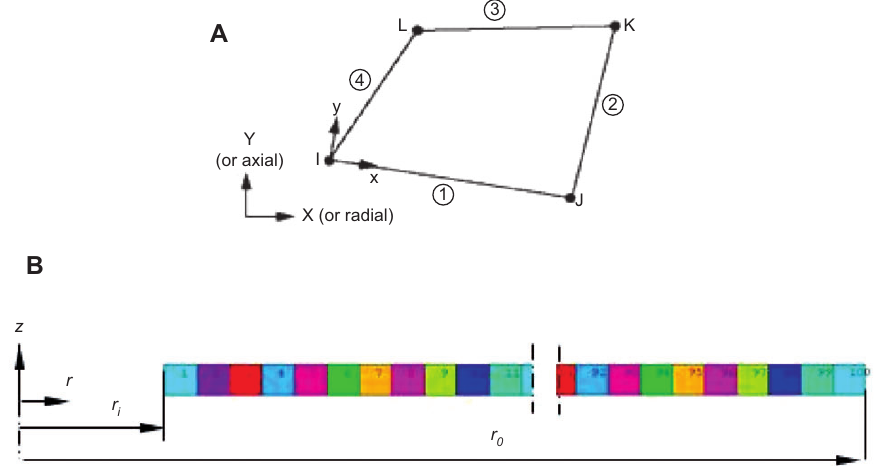
Figure 3 (A) Plane42 element geometry. (B) Cross section of disc meshed by 100 axisymmetric elements.